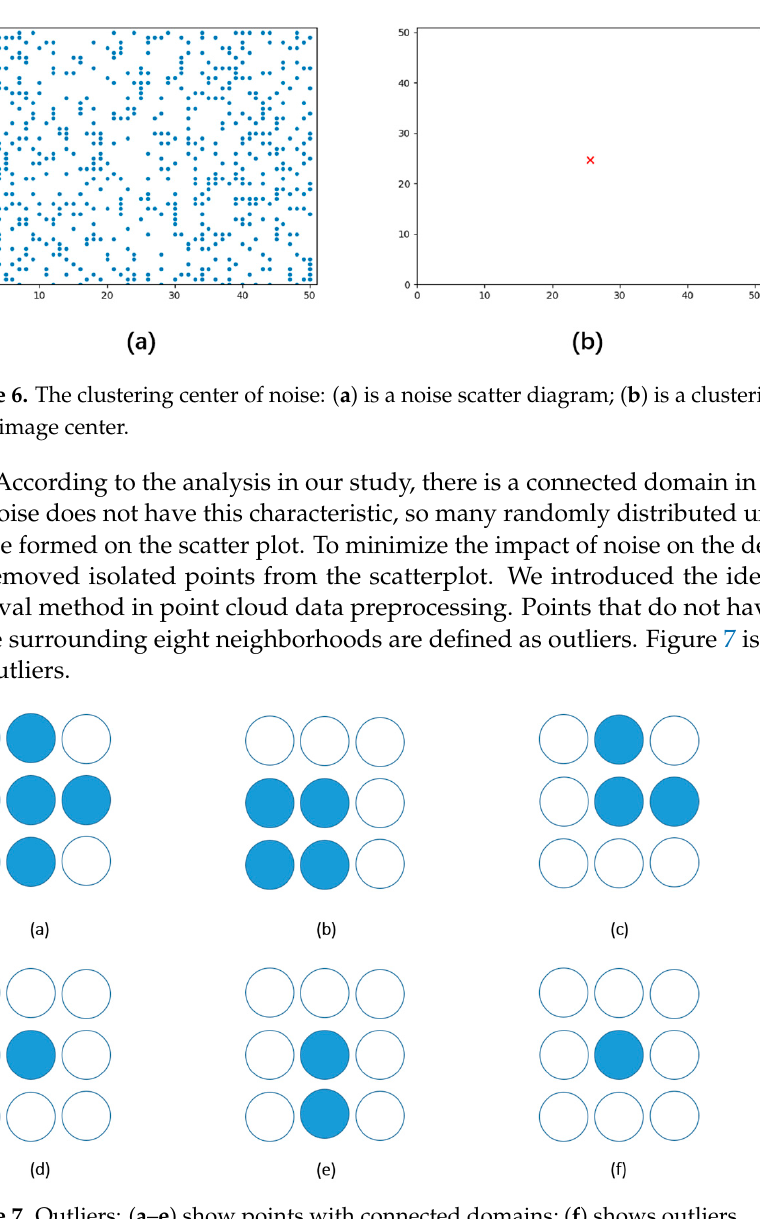
Figure 8. Experimental results from 0.5 to 1.5 dB: ( a – c ) are the original images. ( d – f ) are the results of 8-neighbour. ( g – i ) the results of 4-neighbour.